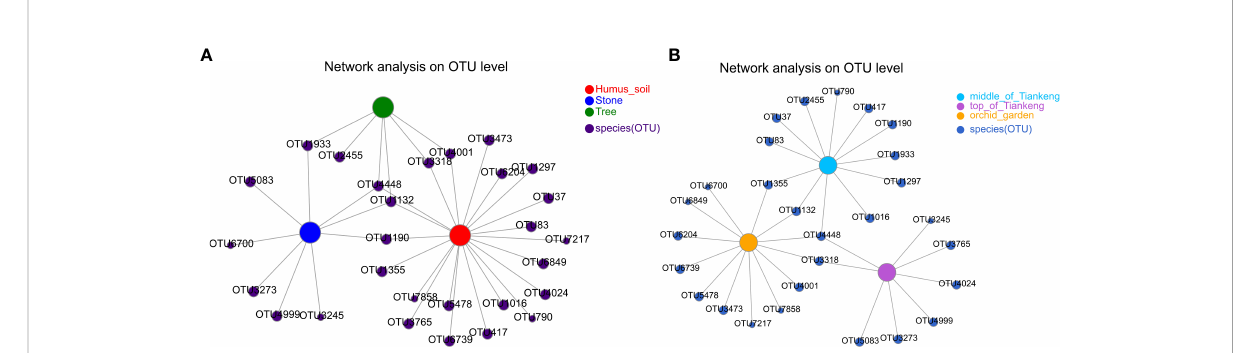
FIGURE 8 Co-occurrence network diagram. Co-occurrence relationship of species in different samples is visually displayed. Nodes in the network represent sample nodes or species nodes, and the connection between sample nodes and species nodes represents the sample containing the species. (A) : different habitat groups; (B) : different altitude